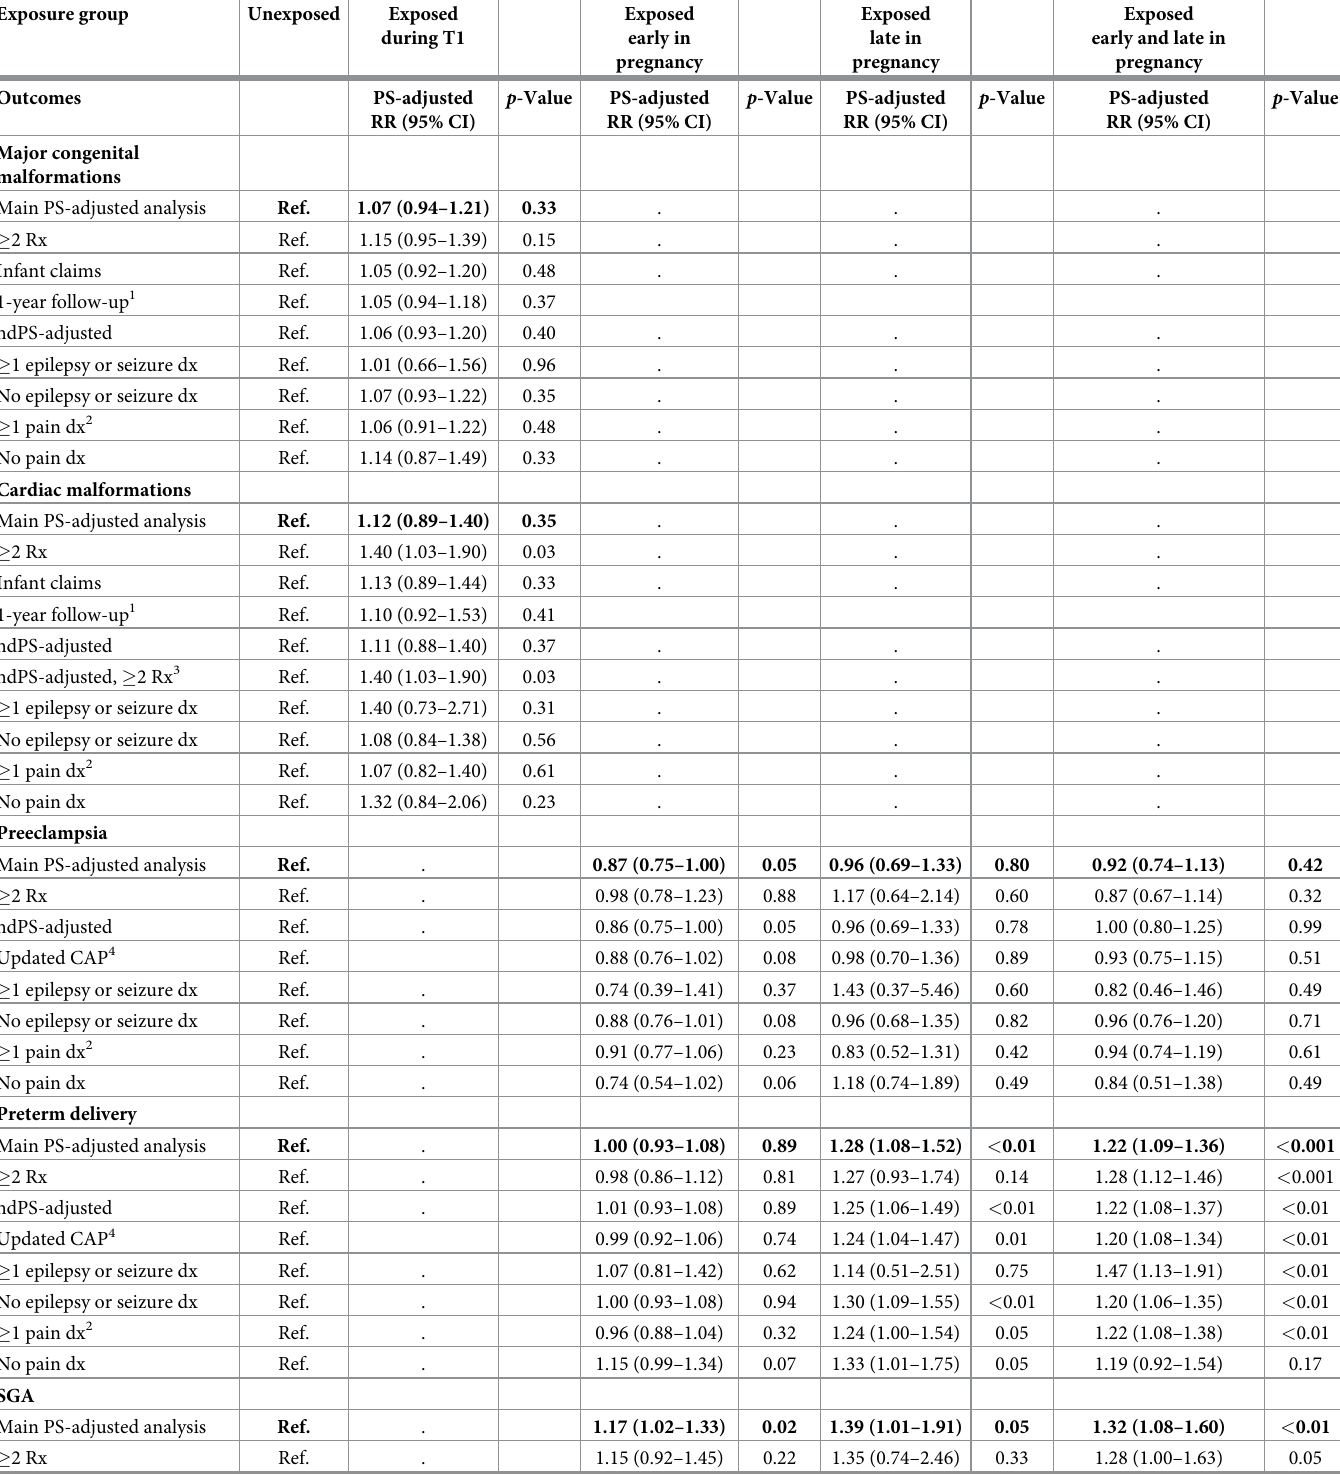
Table 3. Sensitivity and secondary analyses for the RRs of neonatal and maternal outcomes associated with exposure to gabapentin compared with unexposed preg- nancies after PS